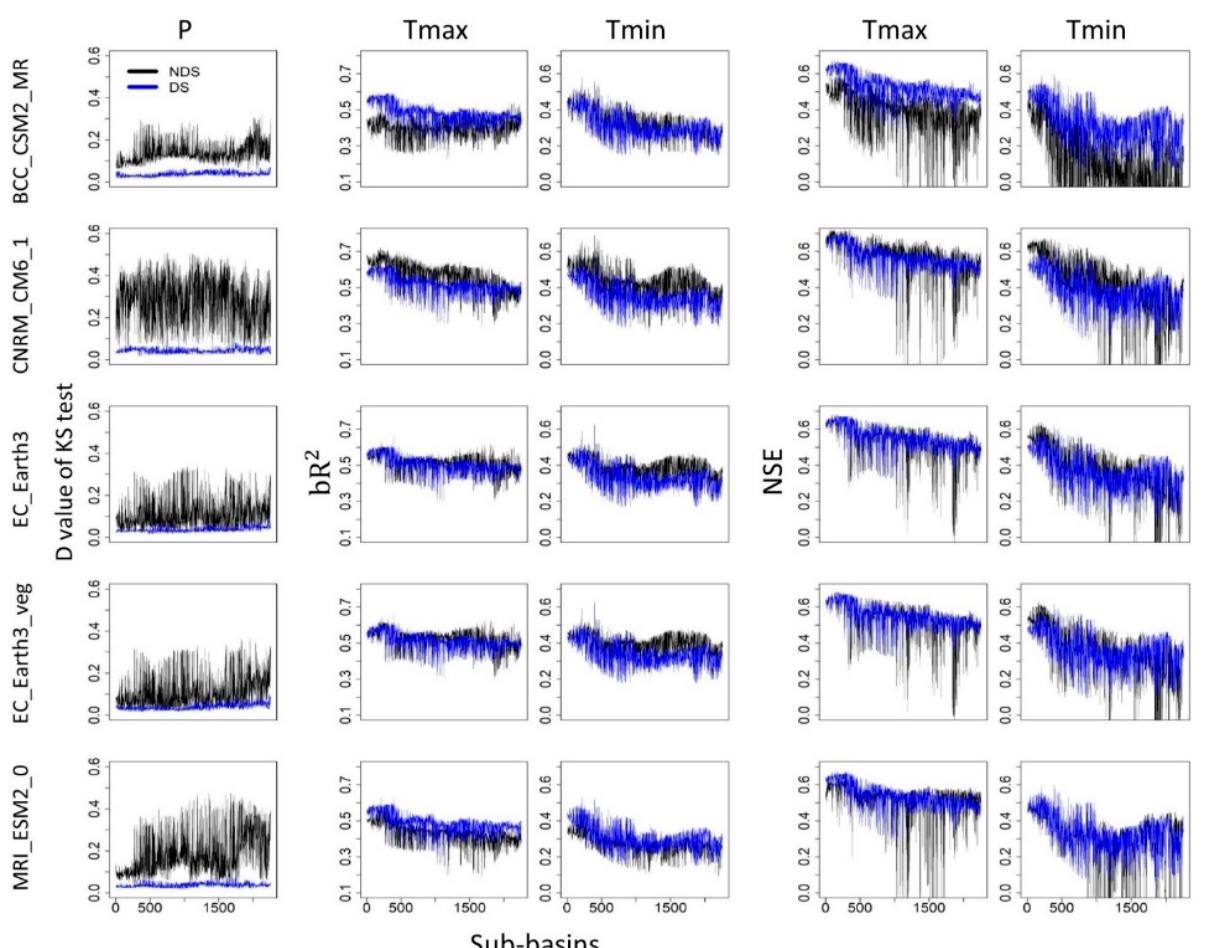
Figure 11. The verification metrics between GCM simulations (downscaled: DS and non-downscaled: NDS) and observed data for the period of 1983–2014. The x-axis represents the 2255 sub-basins in Alberta and y-axis represents the corresponding evaluation metric for daily P, Tmax, and Tmin. The negative values of NSE were ignored and the x-axis was set at 0.